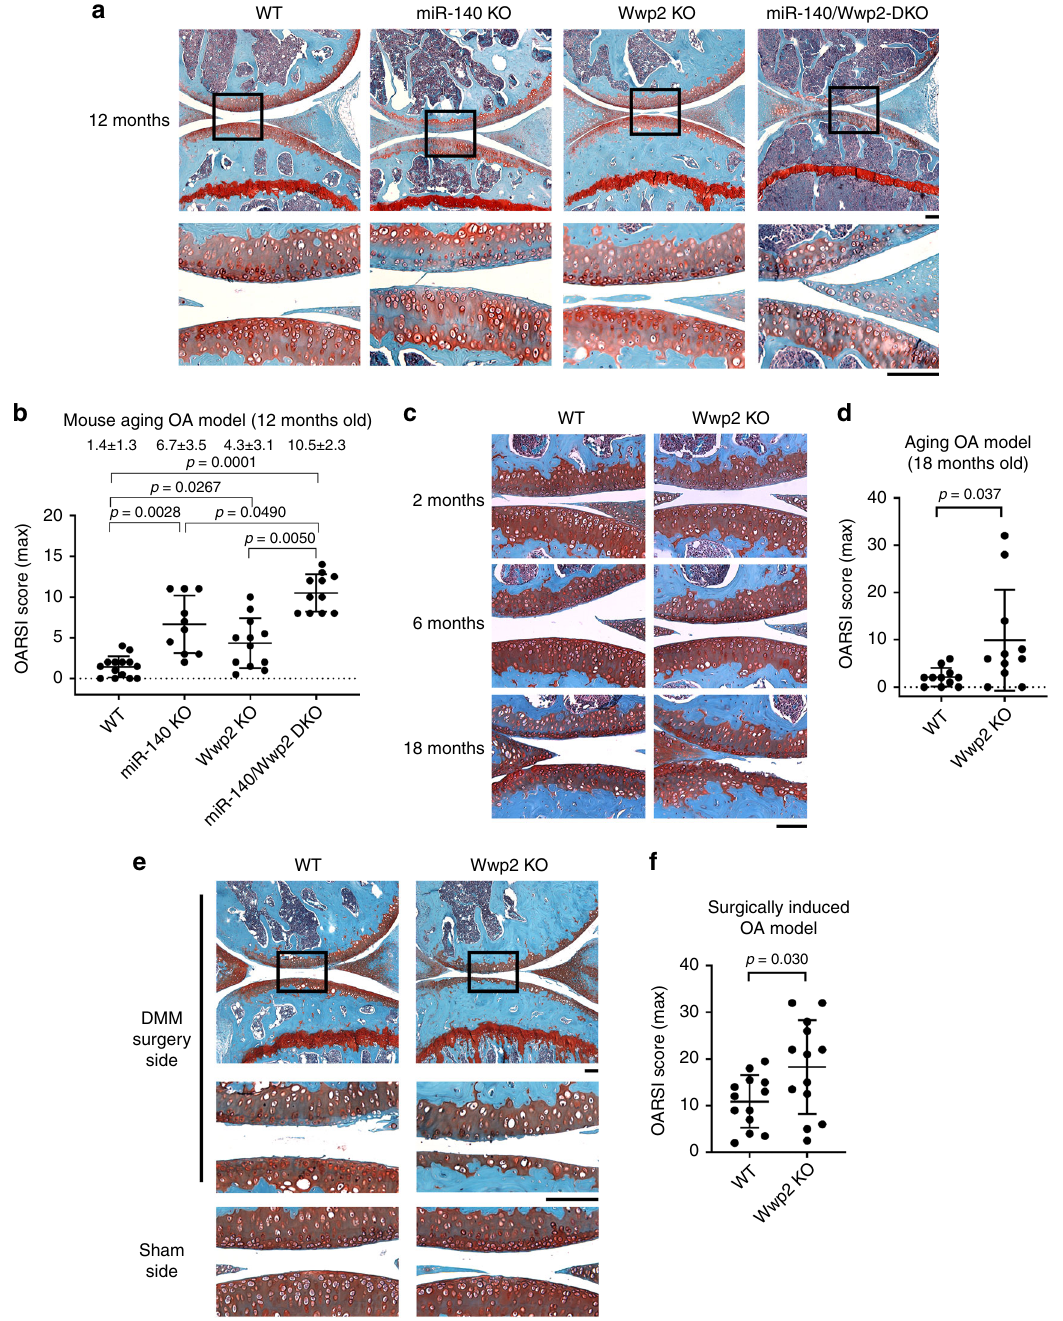
Fig. 1 Loss of Wwp2 exacerbates articular cartilage destruction. a , b . Results of aging (12-month-old) OA murine model compared among wild type (WT), miR-140 KO ( miR-140 14del/14del ), Wwp2 KO ( Wwp2 1ins/1ins ) and miR-140/Wwp2-DKO ( Wwp2 1del/1del ; miR-140 132del/132del ) mice. a Representative images of Safranin-O staining. b The OARSI scores ( n = 10-14, Dunn test compared with WT and DKO, respectively). c Representative images of Safranin-O staining of WT and Wwp2 KO mice (2, 6, 18-month-old). d The OARSI scores of WT and Wwp2 KO mice in 18-month-old ( n = 11, Welch ’ s t test). e , f Results of surgically (DMM) induced OA murine model compared to WT and Wwp2 KO mice. e Representative images of Safranin-O staining. f The maximum OARSI scores of WT and Wwp2 KO mice ( n = 13, Student ’ s t test). Black scale bar = 1 mm. Source data are provided as a Source Data fi le. Data are presented as the mean ±